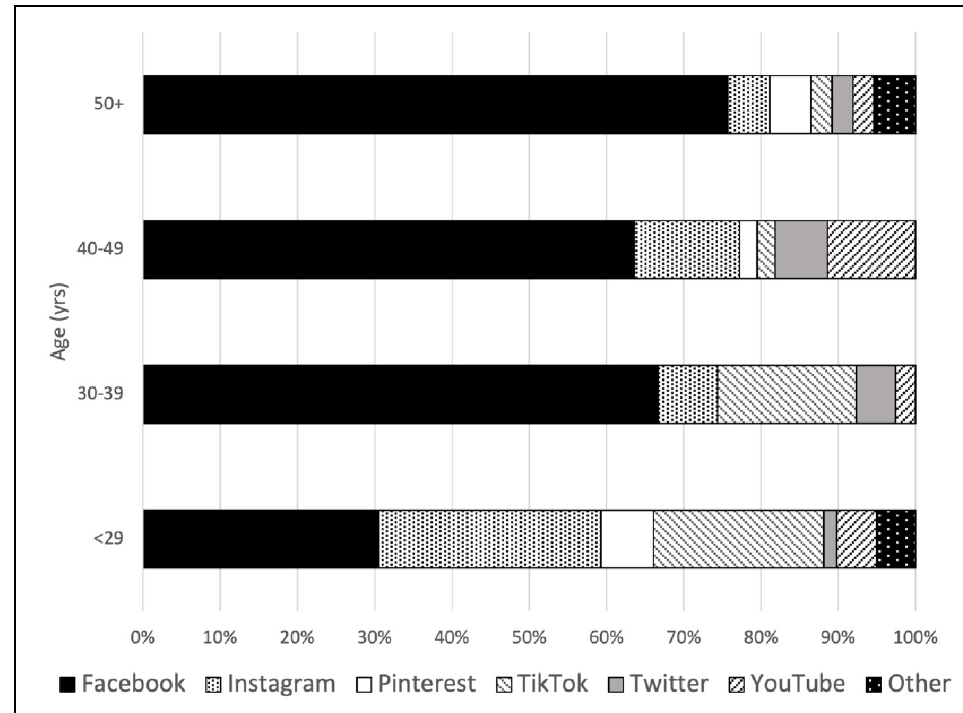
Figure 1. Social media platform use during the COVID pandemic by age among Canadian survey respondents; June 2021–October 2021 (n =